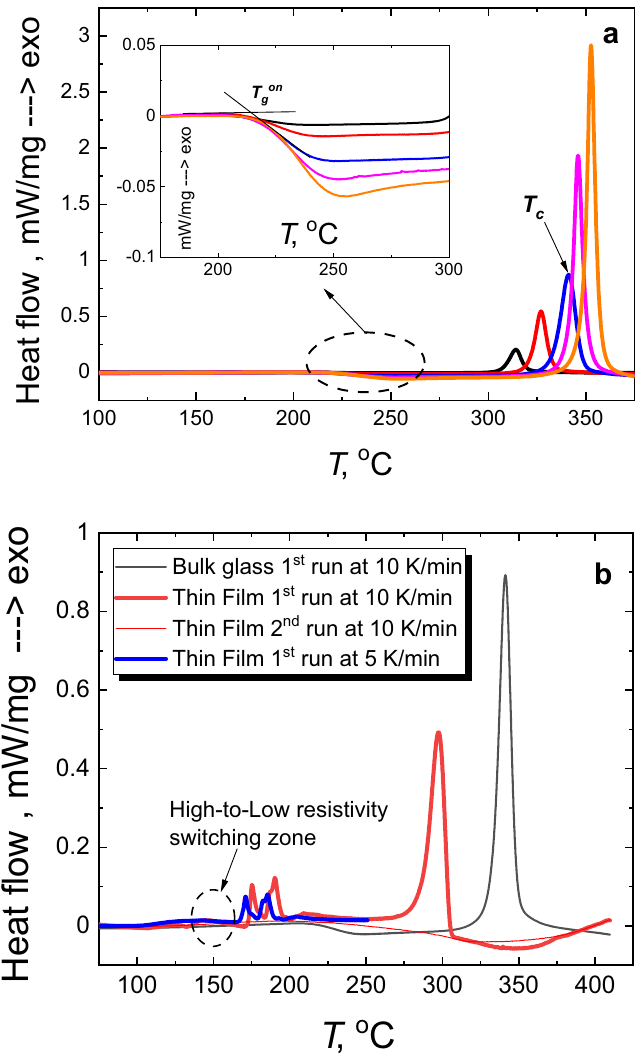
Figure 3. DSC curves of as-prepared bulk Ge 15 Sb 40 S 15 Se 15 Te 15 glass and thin film. ( a ) DSC signals for the bulk samples were recorded with 2 (black), 5 (red), 10 (blue), 15 (magenta) and 20 (orange) K/min heating rates. They show glass transition range (insert) and exothermal crystallization peaks above 300 °C. ( b ) DSC curves of thin